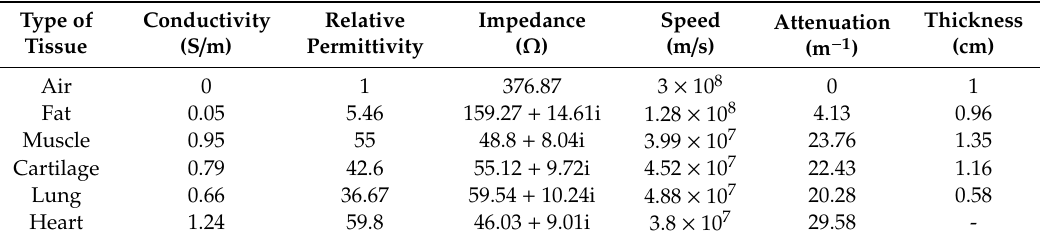
Table 1. Electromagnetic (EM) properties of human-body tissue at 915 MHz.